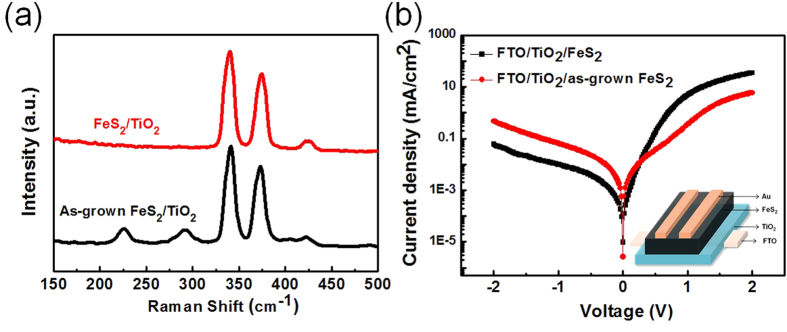
(a) Raman spectra of as-grown FeS2/TiO2 photoanode and FeS2/TiO2 photoanode. (b) The dark current of TiO2/ as-grown FeS2 and TiO2/FeS2 devices.